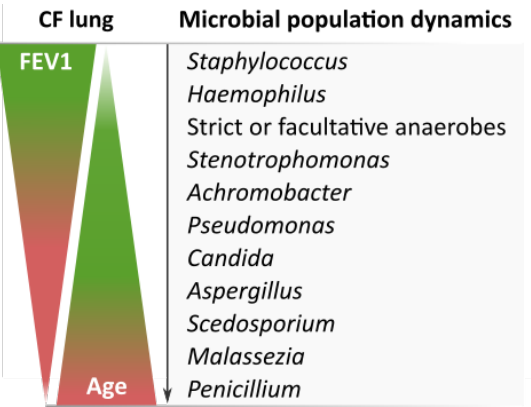
Figure 6. Evolution of microbial communities in the CF lung (according to [26]). The most relevant bacteria and fungi are named in order of settlement. bacteria and fungi are named in order of